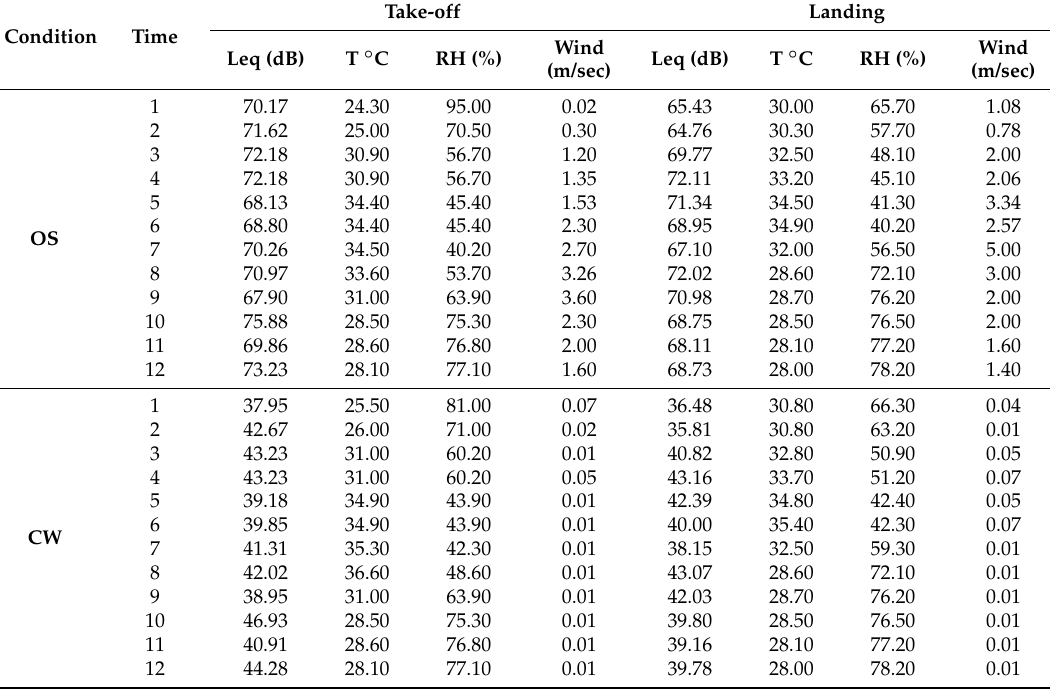
Table 10. Climate influence to noise